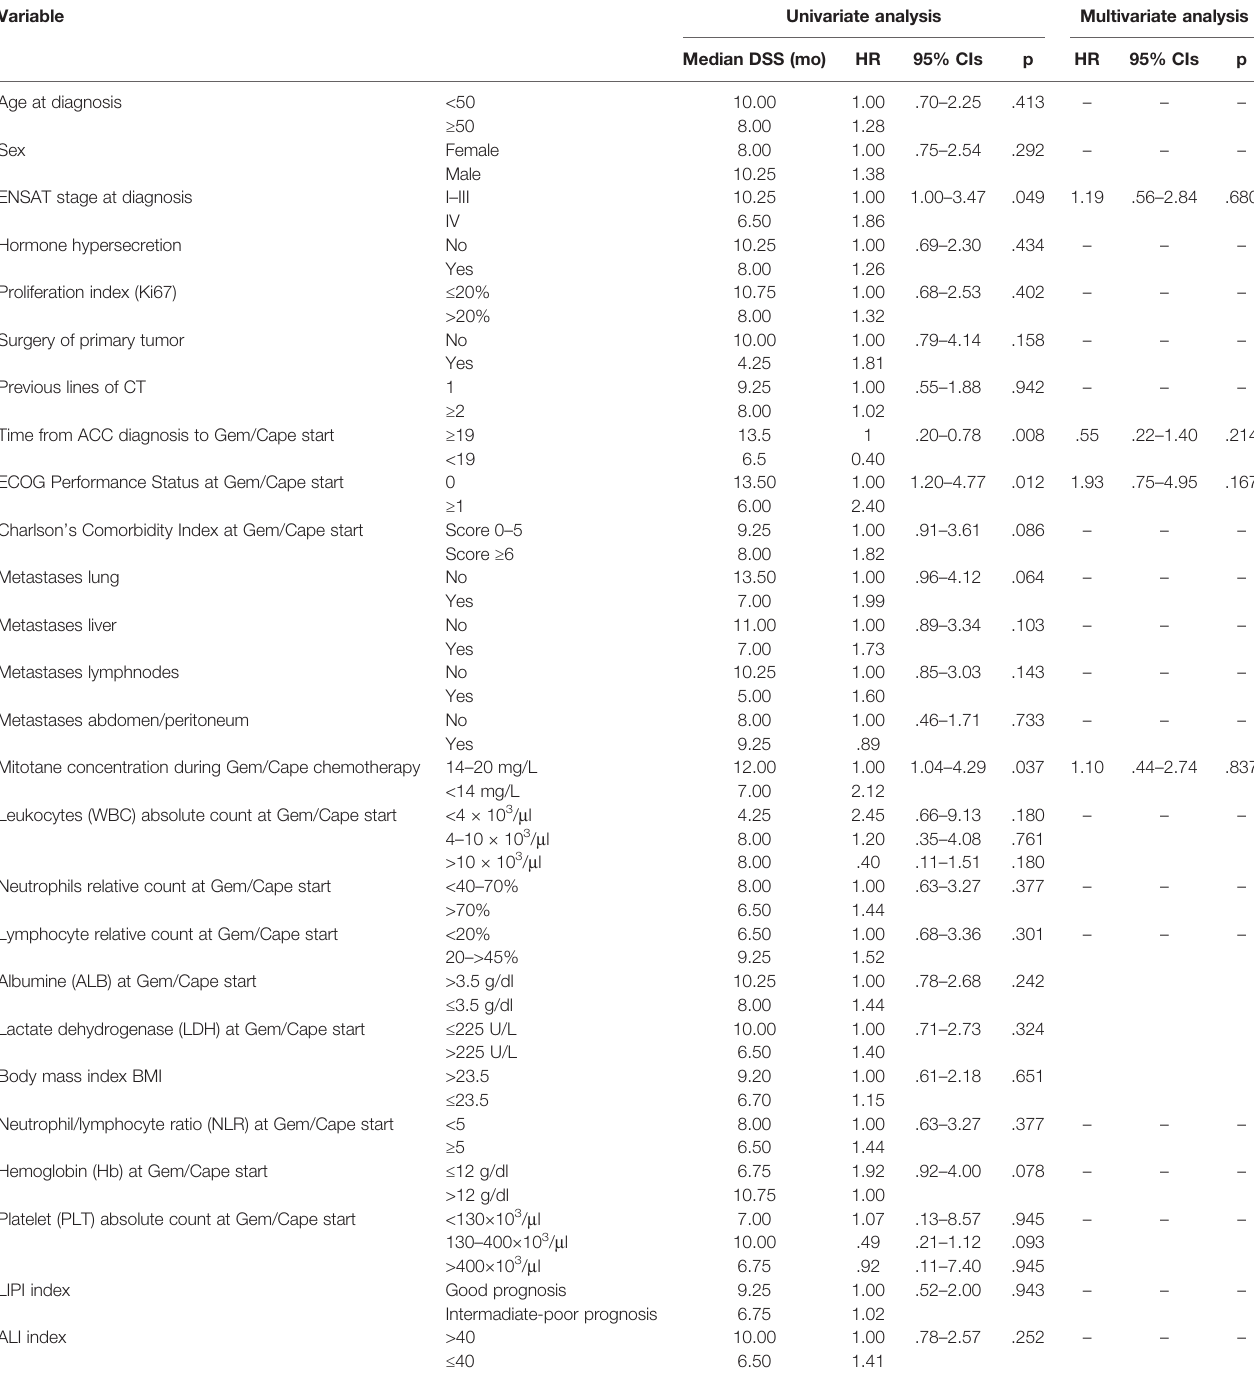
TABLE 4 | Uni- and multivariate analysis of clinico-pathological factors prognostic of disease-speci fi c survival